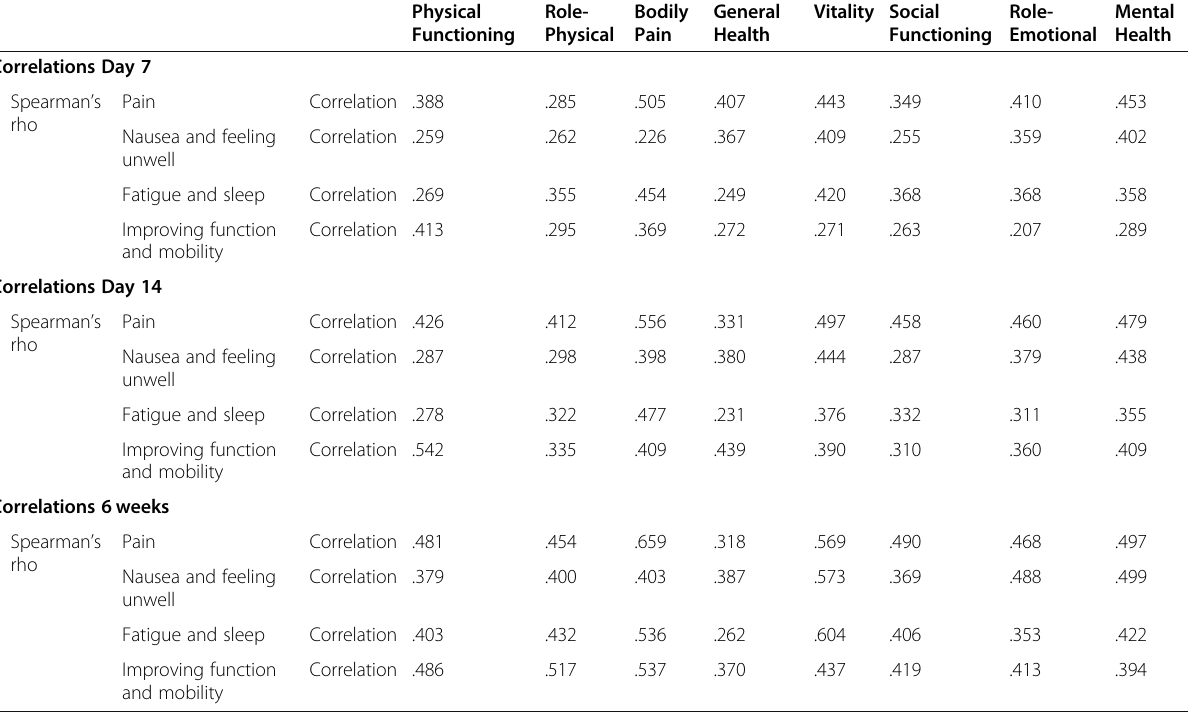
Table 15 Spearman ’ s rho correlations for domains of the OARS and SF-36v2 acute health domain scores at days 7, 14 and 6